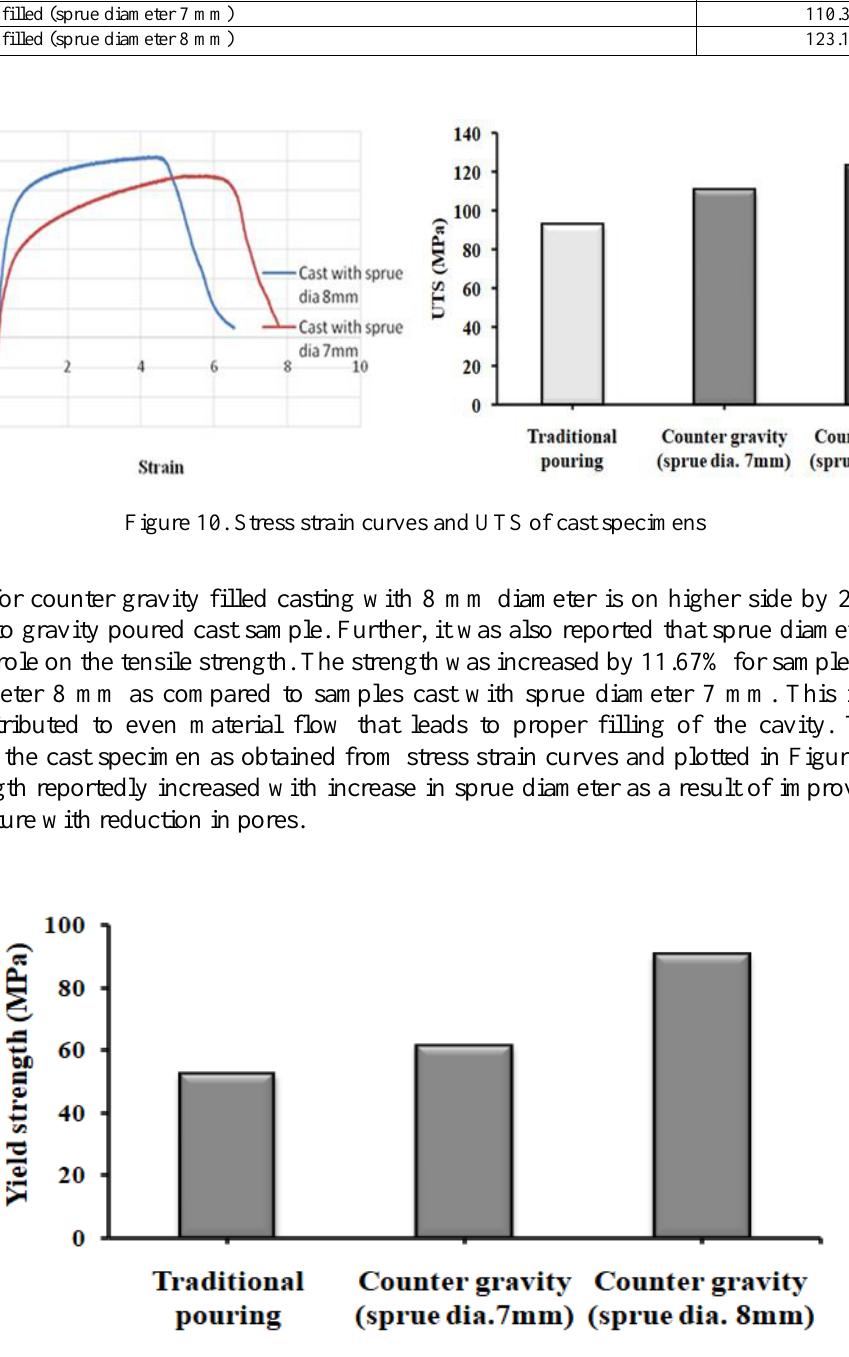
Figure 11. Yield strength of cast